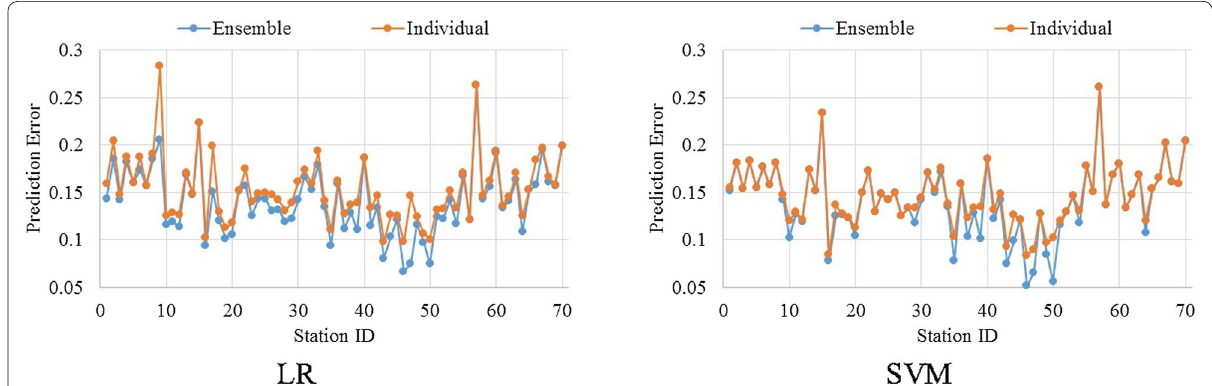
Fig. 8 Comparison of day-ahead prediction error between ensemble and individual classifier. Table 4 in appendix details the empirical results